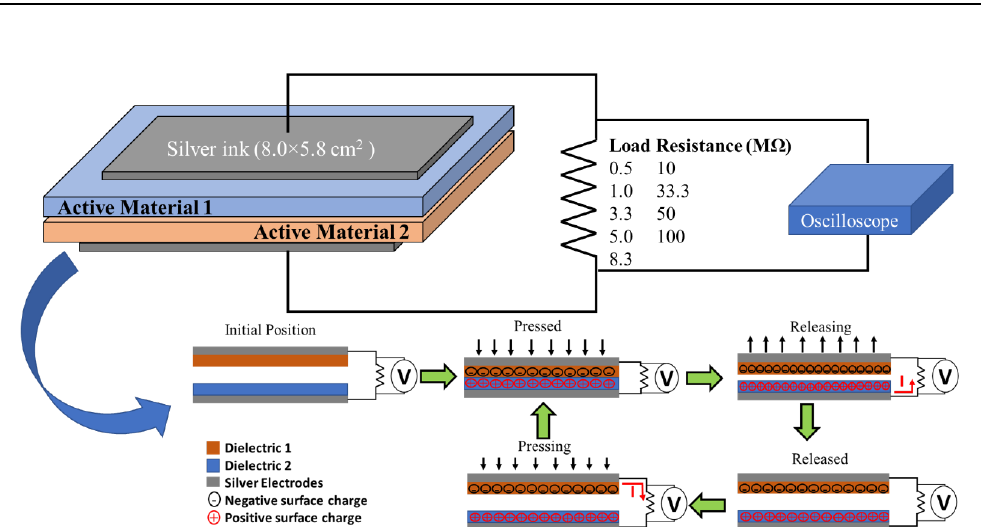
Figure 1. Illustration of the geometry of the samples with the active material, screen-printed silver ink electrodes and their connection to the Picoscope 2205A using load resistances of 0.5, 1, 3.3, 5, 8.3, 10, 33.3, 50 and 100 MΩ, above. Experimental method used for the triboelectric evaluation of the different pair of materials in a contact-separation mode, below. The force applied in each step is about 10 N.